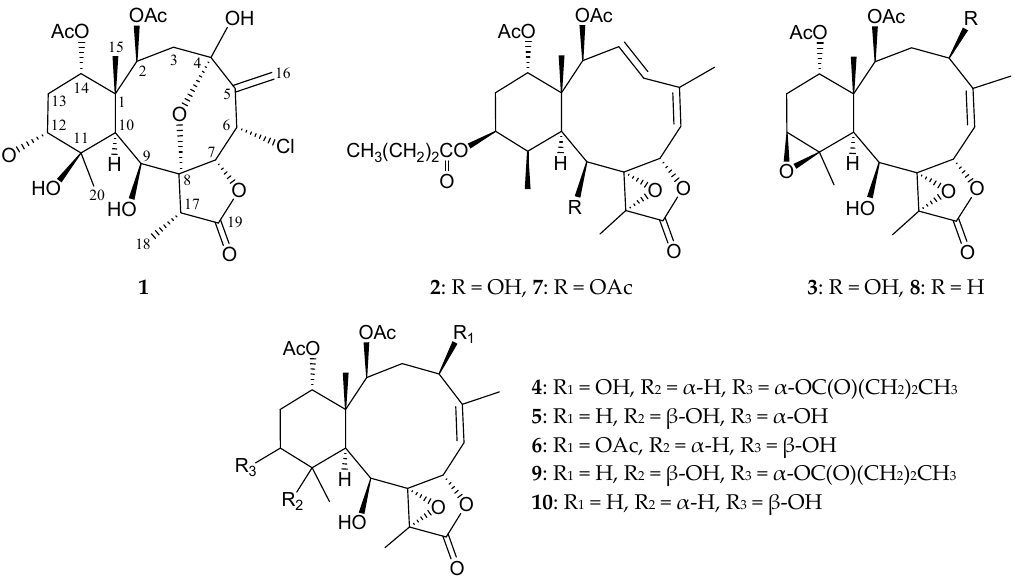
Figure 1. The structures of briarenolides ZI–ZVI ( 1 – 6 ), excavatolide F ( 7 ), 2 β -acetoxy-2- (debutyryloxy)-stecholide E ( 8 ), excavatolide Z ( 9 ) and excavatolide E ( 10 ).